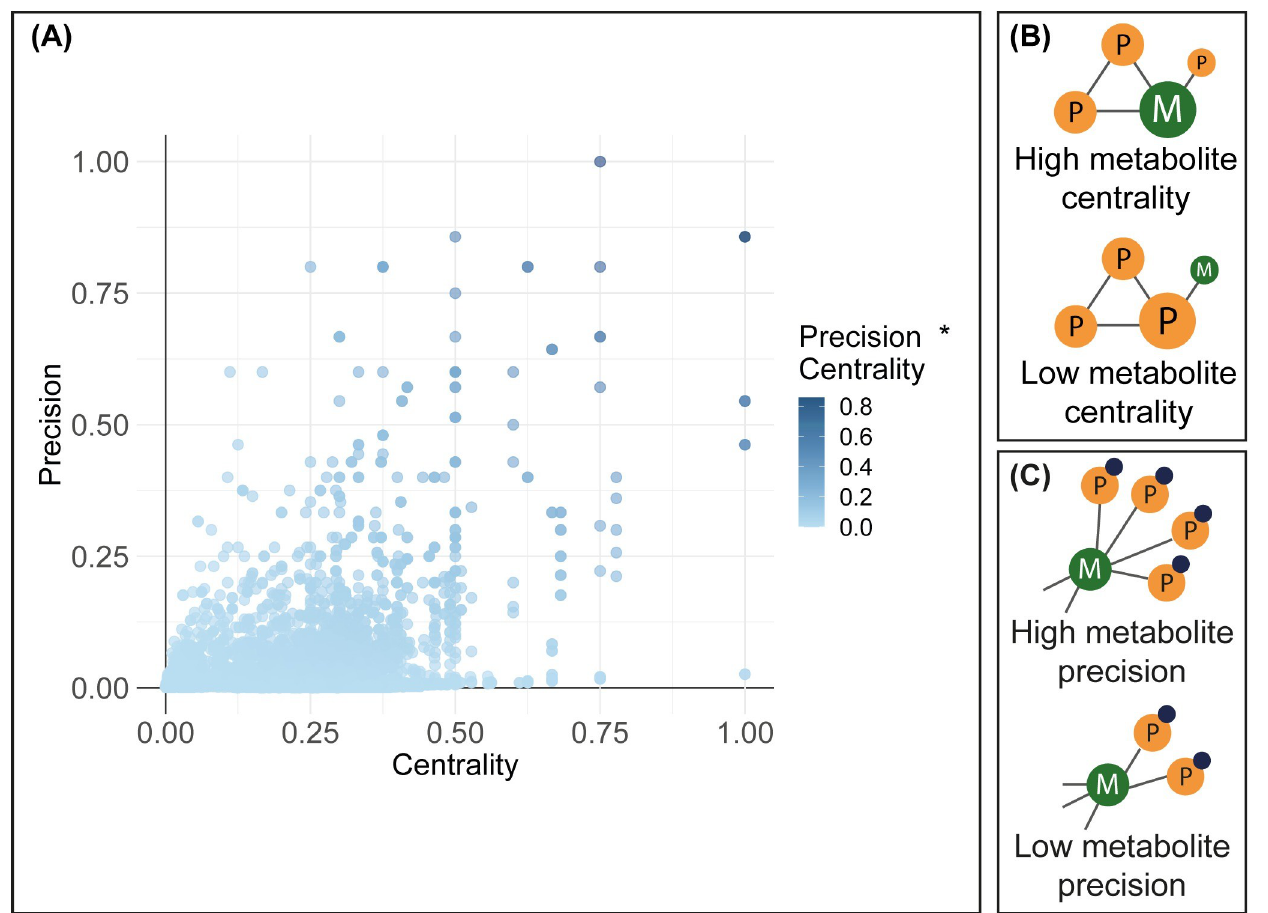
Fig 6. Precision-centrality plot of the significant metabolite-immune process associations in the IMA excluding lipids. (A) For each metabolite in each immune process, the centrality and precision were calculated and normalized to the network size. Metabolites with high centrality and precision scores might be of interest as biomarkers for the associated immune process (B) The centrality represents the position of a metabolite in the network. (C) The precision represents the exclusivity of the metabolite for a certain immune process.